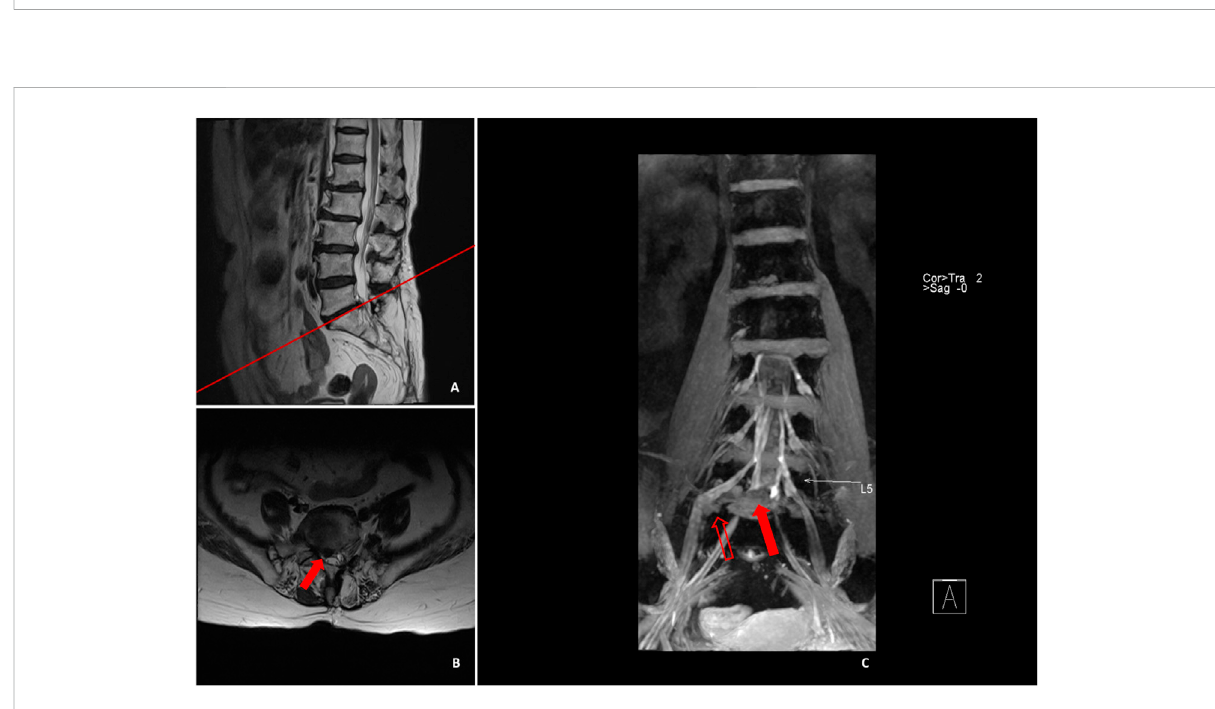
FIGURE 6 Sagittal (A) and cross-sectional MRI (B) image illustrated that L5/S1 protruded to the right side, and the preoperative physical examination manifested that the skin sensation of the dorsum and plantar of the lateral side of the right leg was decreased, with positive results in straight leg raising test. 3D-DESS (C) illustrated that the intervertebral disc on L5/S1 segment protruded to the right side in the spinal canal, compressing the S1 nerve root (red solid arrow), whereas the L5/S1 extreme lateral nucleus pulposus (red hollow arrow) also compressed the L5 nerve